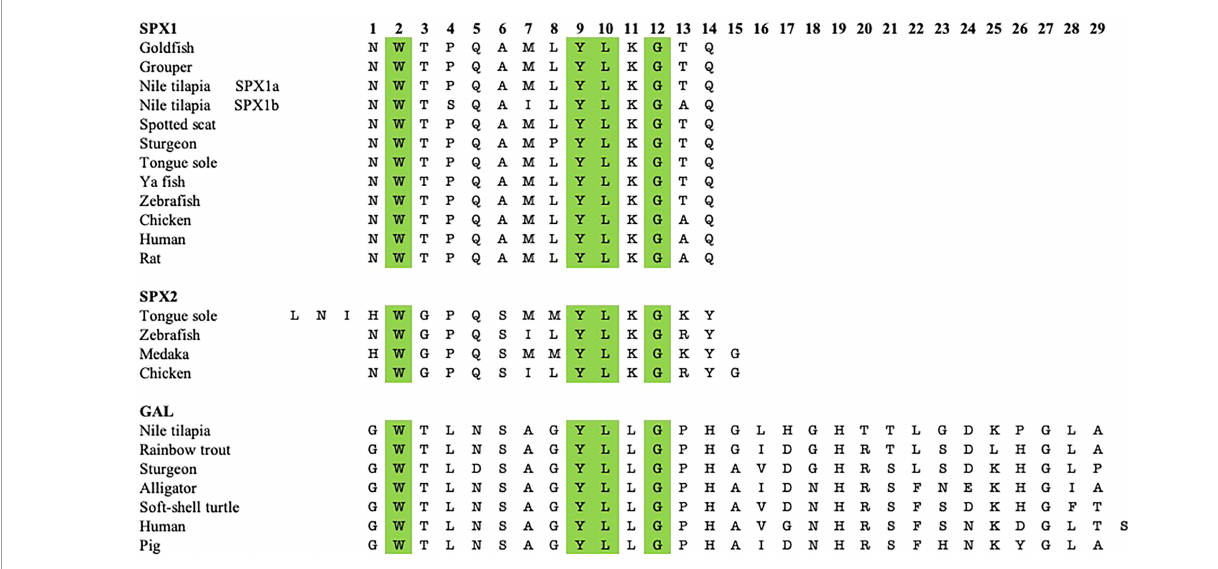
FIGURE 1 | Sequence comparison between the mature peptide sequences of SPX1, SPX2, and GAL of various non-mammalian vertebrate species with some tetrapods. Both SPXs are 14 amino acids long, except for tongue sole SPX2, which is 17 amino acids long. GAL is mostly 29 amino acids long, Amino acids at positions 2, 9, 10, and 12 are conserved across the three